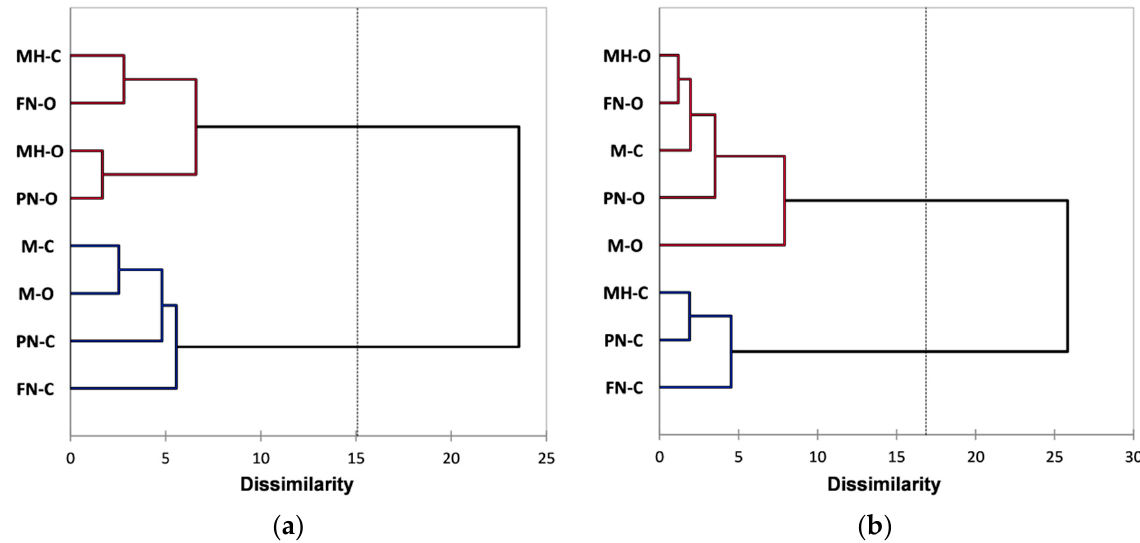
Figure 9. Dendrograms showing the cluster patterns for red grape pulp extracts based on: ( a ) FTIR data; ( b ) Raman data.